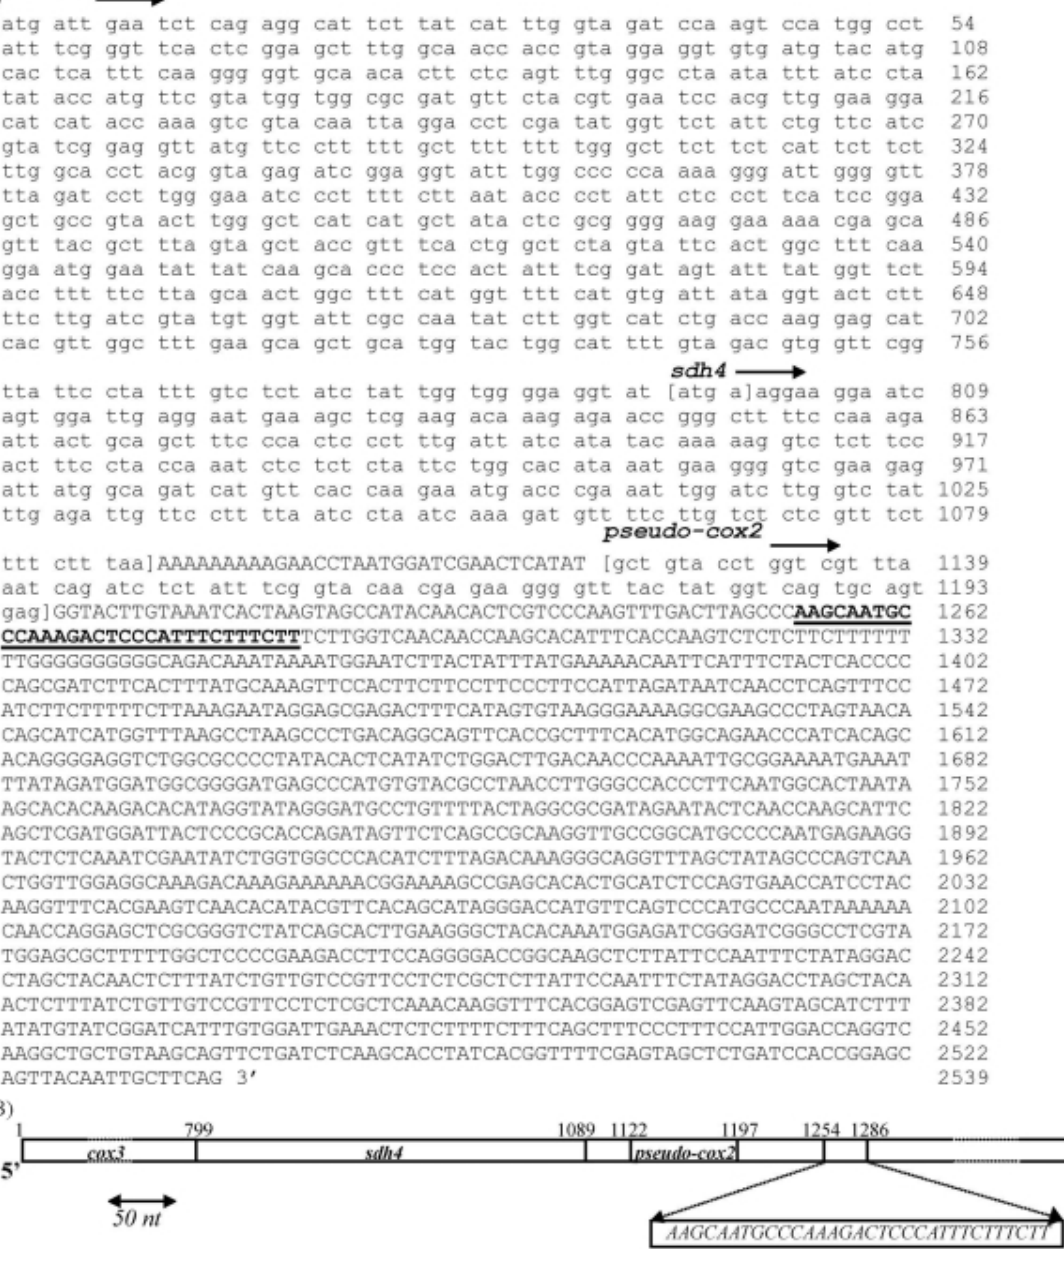
Figure3 -Diagrams(nottoscale)showingthepositionoftheconservedpotatomitochondrialsequence.(A)Linearnucleotidepotatosequence.The atga sequence at site 795 indicates the atg start codon for sdh4 and the tga stop codon for cox3 . Nucleotide numbers are shown on the right and square brackets indicatethestart/stopforeachgene.The32ntrecombinatorysequenceconservedinsomegenomesisunderlinedandinbold.(B)Representativediagram showingthetotalsequenceanalyzedinthisresearch.Numbersabovethebarindicatethestartandstoppositionsforthe cox3 and sdh4 genes,pseudo- cox2 and the 32 nt conserved sequence (in evidence below the diagram). Each cm in the bar corresponds to 50